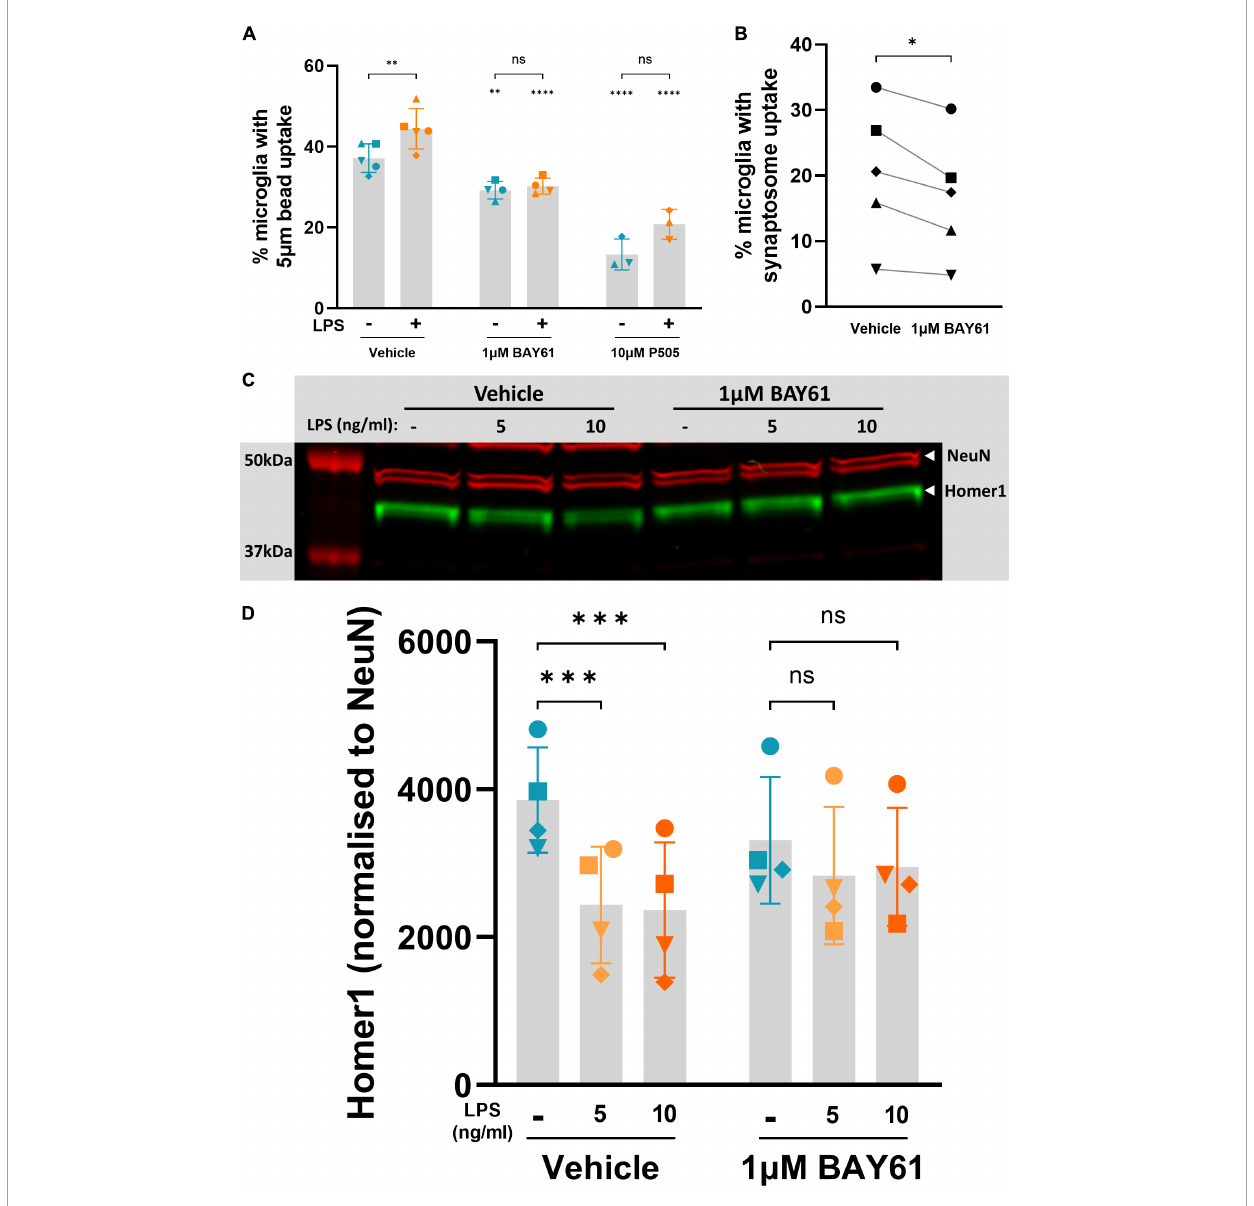
FIGURE6 Syk inhibition decreases microglial phagocytosis of synaptic material. (A) Average percentage of non-necrotic microglia that took up fluorescent 5 µ m beads over 2 h, after 24-h treatment ± BAY61 (1 µ M) or ± P505 (10 µ M), and ± LPS (100 ng/ml), as measured by flow cytometry. RM mixed-effects analysis with Šídák’s post-hoc test. (B) Average percentage of non-necrotic microglia that took up pHrodo-labelled synaptosomes over 2 h, after 24-h treatment ± BAY61 (1 µ M), as measured by flow cytometry. Paired t -test. (C) Representative Western blot on lysates from neuron-glia cultures treated ± BAY61 (1 µ M) and ± LPS (5-10 ng/ml) for 3 days (DIV10). Red = NeuN, green = Homer1. (D) Homer1 signal normalised against NeuN signal from Western Blots of lysates from neuron-glia cultures treated ± BAY61 (1 µ M) and ± LPS (5–10 ng/ml) for 3 days (DIV10). RM 2-way ANOVA with Šídák’s post-hoc test. Datapoints in panels (A,B) represent the mean of three technical replicates. All panels: Number of biological repeats = number of datapoints per column. ∗ p < 0.05, ∗∗ p < 0.01, ∗∗∗ p < 0.001, ∗∗∗∗ p <